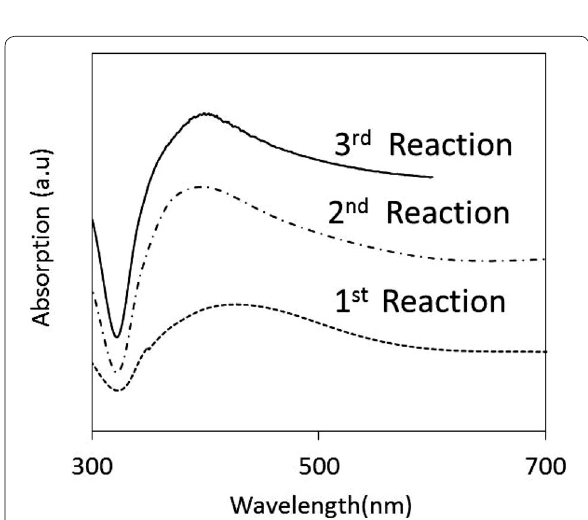
Fig. 5 Absorption spectra of PDMS films depending on the number of rounds of the additional AgNP-growth